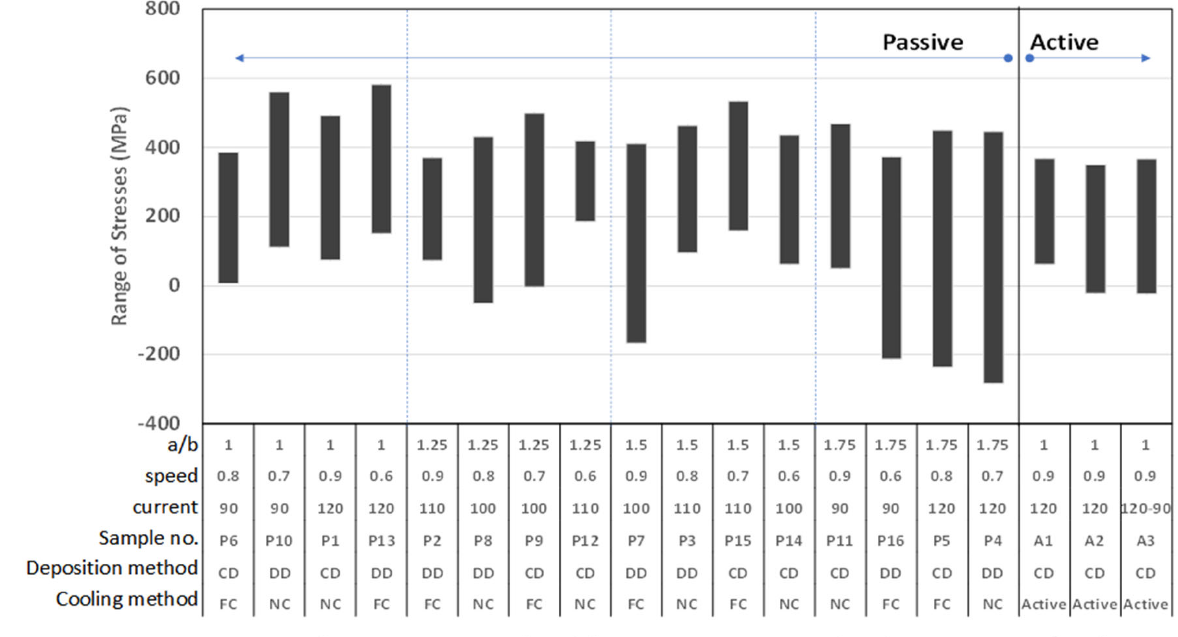
Figure 9. Distortion plots for an active set of experiments.